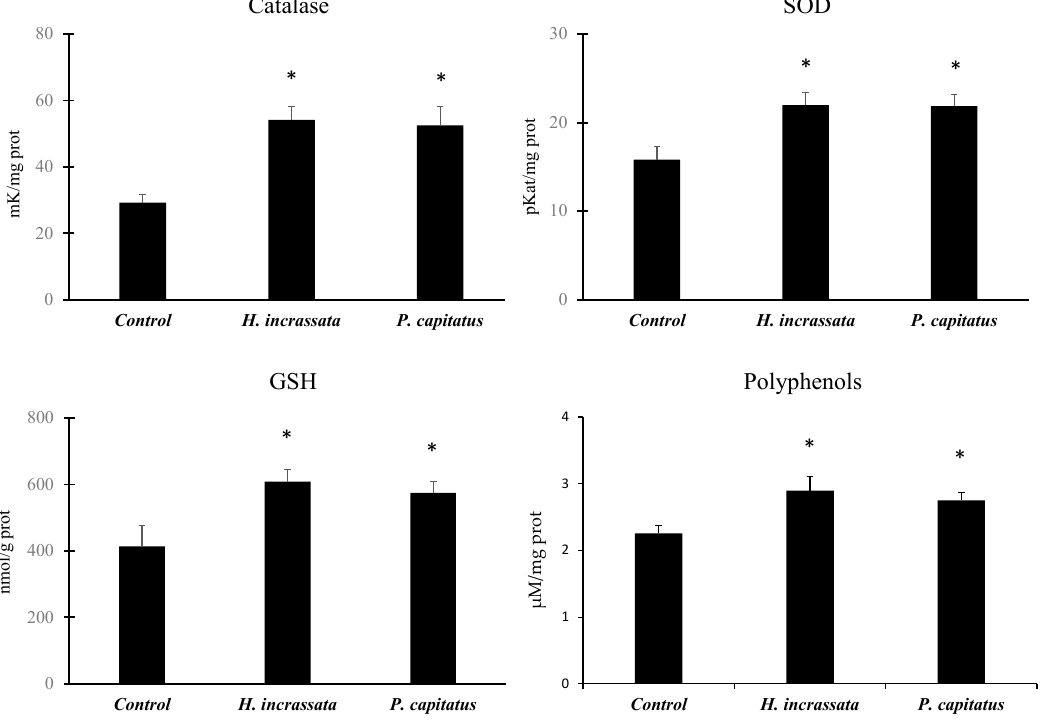
Figure 3. Antioxidant enzyme activities, catalase and superoxide dismutase (SOD), and non-enzymatic antioxidants reduced glutathione (GSH) and polyphenols in samples of P. pavonica (control) alone or coexisting with the invasive H. incrassata or P. capitatus . * Indicates significant differences compared to control (one-way ANOVA). Values are expressed as mean ± S.E.M. The levels of MDA and the production of H 2 O 2 are shown in Figure 4. The presence of the invasive algae did not increase the MDA levels of P. pavonica , and although there was a tendency to increase the production of H 2 O 2 , the differences were not statistically significant.